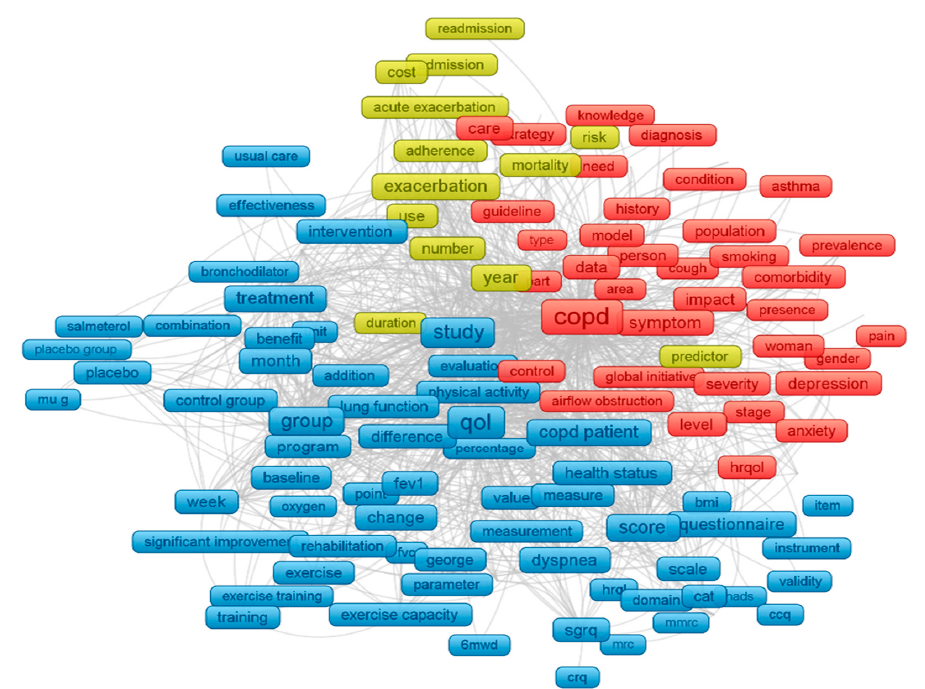
Figure 2. Text mining using VOSviewer (titles and abstracts). Note: the colors of each node were automatically assigned by VOSviewer based on its score; the node size was based on the frequency of each term; the length and thickness of the lines reflected the association between two terms. Cluster 1 (red) refers to comorbidity and COPD; cluster 2 (blue) focuses on interventions and treatment to increase QoL of people with COPD, cluster 3 (yellow) points out the risk and mortality of exacerbation of COPD.